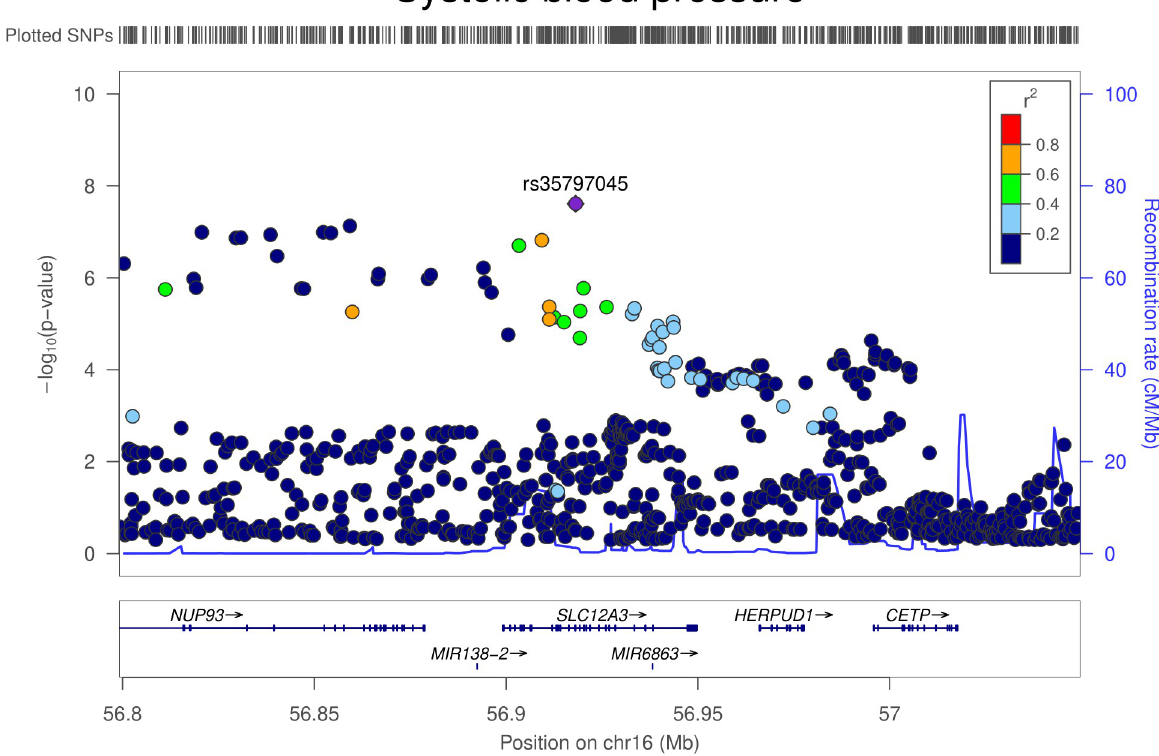
Fig 5. Regional Manhattan plot of associations of SNPs with SBP ± 300kb from the SNP used to proxy SBP (rs35797045) in the SLC12A3 region. Mb, Megabase; SBP, systolic blood pressure; SNP, single-nucleotide polymorphism.